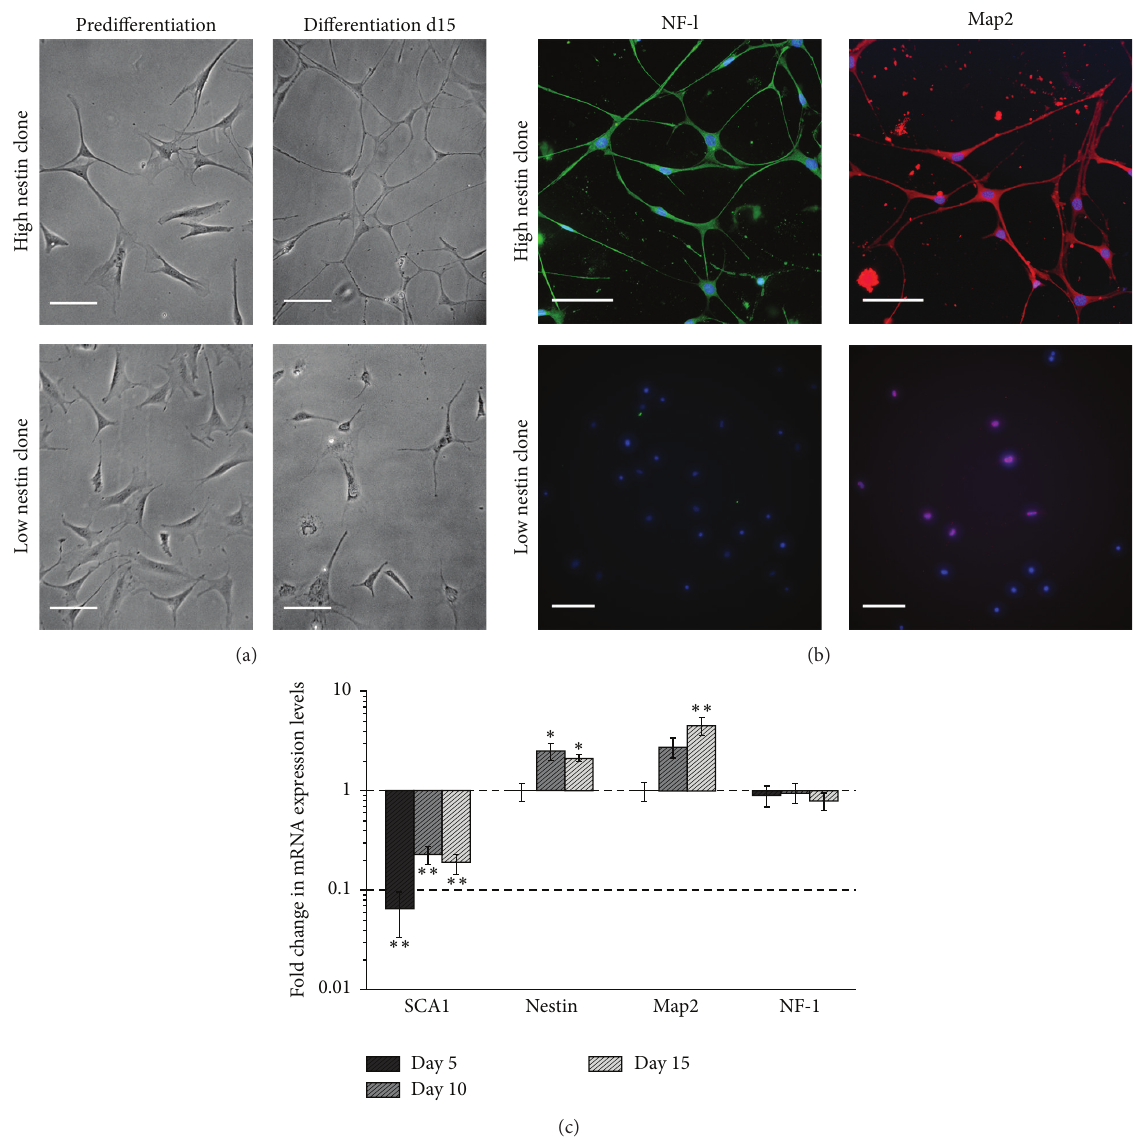
Figure 2: Only high nestin-expressing mDPSC clones possess the ability to differentiate into neuronal-like cells. (a) Representative phase contrast images of high (clone 2) and low (clone 3) nestin-expressing clones prior to and following 15 days of neuronal differentiation demonstrating a more neuronal-like morphology in high nestin-expressing clones with small refractive cell somas extending multiple interconnecting processes. (b) Immunocytochemical staining identified the presence of microtubule-associated protein 2 (Map2) and NF- l in high, but not low, nestin-expressing mDPSC clones following 15 days of neuronal differentiation. (c) Changes in mRNA expression of mesenchymal and neural markers during neuronal differentiation of high nestin-expressing mDPSC clones (clone 2). Expression levels of target genes were normalized against GAPDH and the 2 −ΔΔ CT method for qPCR analysis used to calculate fold change in expression relative to predifferentiation cells on day 0 ± SEM ( 𝑛 = 3 independent differentiation experiments). One-way ANOVA with Dunnett multiple comparisons posttest to identify significant increases/decreases in expression compared to day 0 cells: ∗ 𝑝 < 0.05 and ∗∗ 𝑝 < 0.01 . Scale bars = 100 𝜇